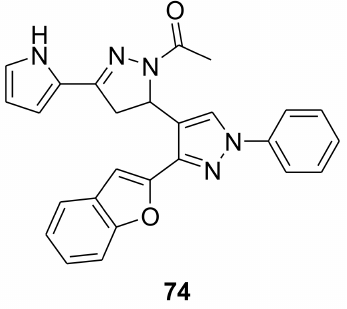
Figure 78. Structure of compound 74 , a Src kinase inhibitor.